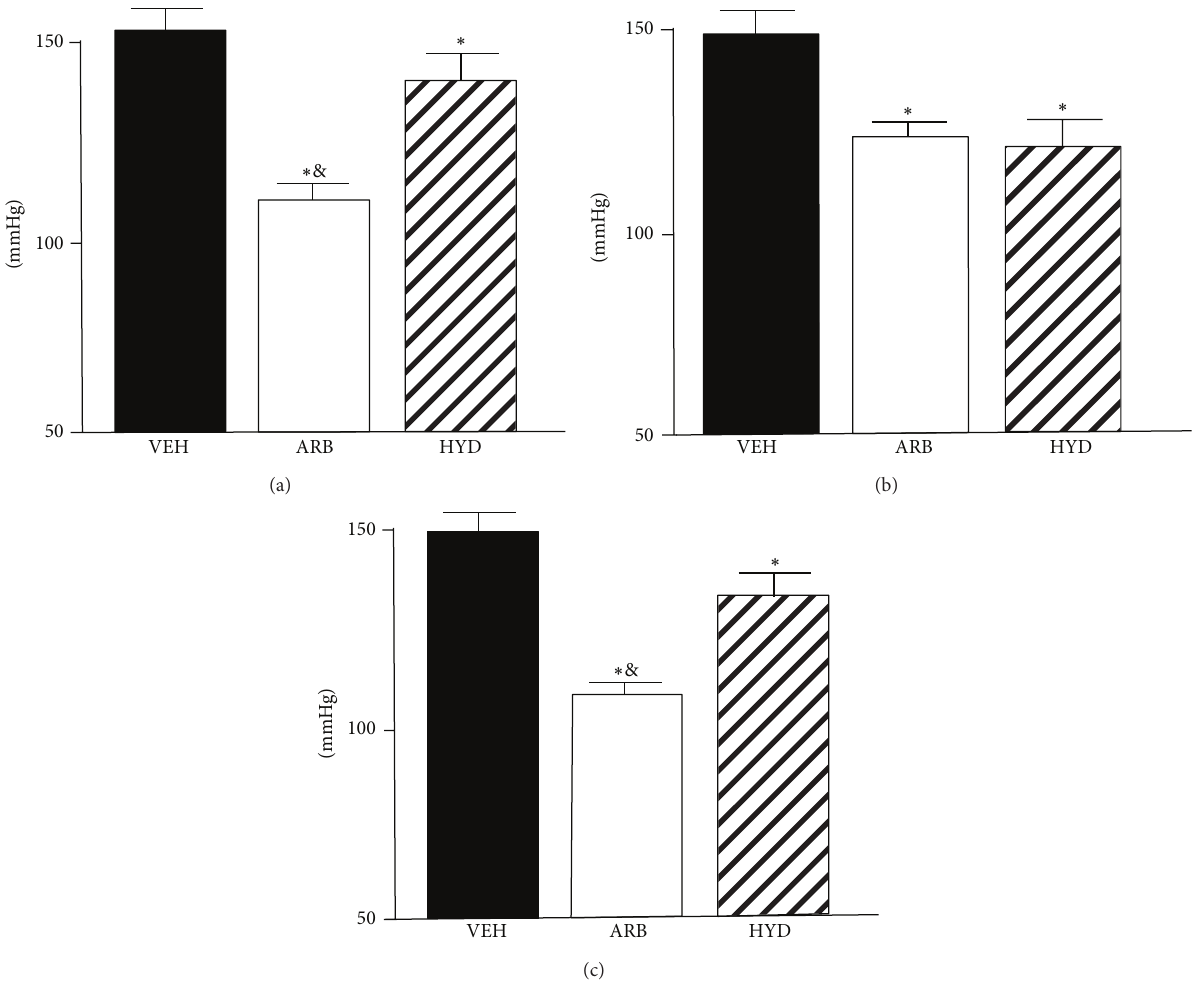
Figure 1: Telemetric averaged mean blood pressure in stroke-prone spontaneously hypertensive rats treated with intracerebroventricular infusion of losartan (ARB, 𝑛 = 5 ), oral-administered hydralazine (HYD, 𝑛 = 5 ), and intracerebroventricular infusion of vehicle (VEH, 𝑛 = 5 ) at early morning (a), after morning (b), and night (c). ∗ 𝑃 < 0.05 versus VEH, & 𝑃 < 0.05 in ARB versus